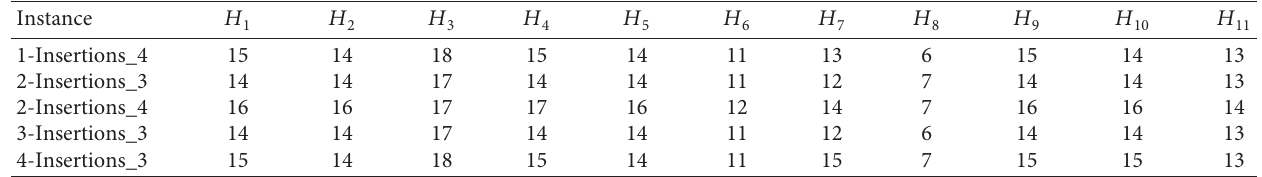
Table 8: Time for one run of each heuristic in seconds for graph coloring